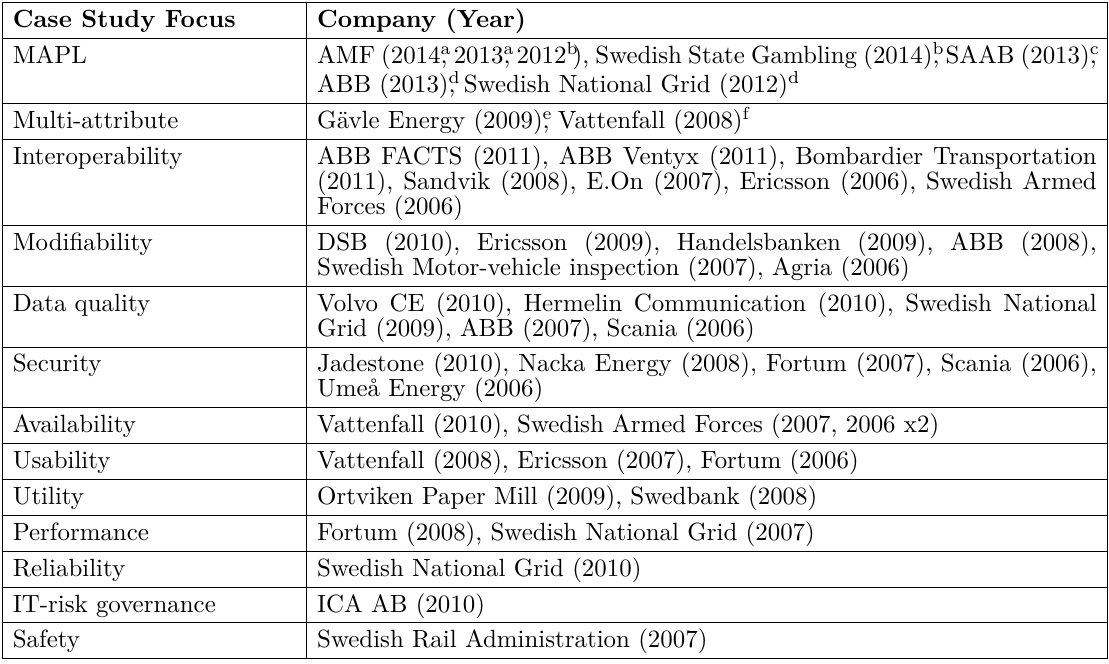
Table 2. Case studies performed 2006-2014 with master students in the course EH2781 IT Management with Enterprise Architecture II, Case